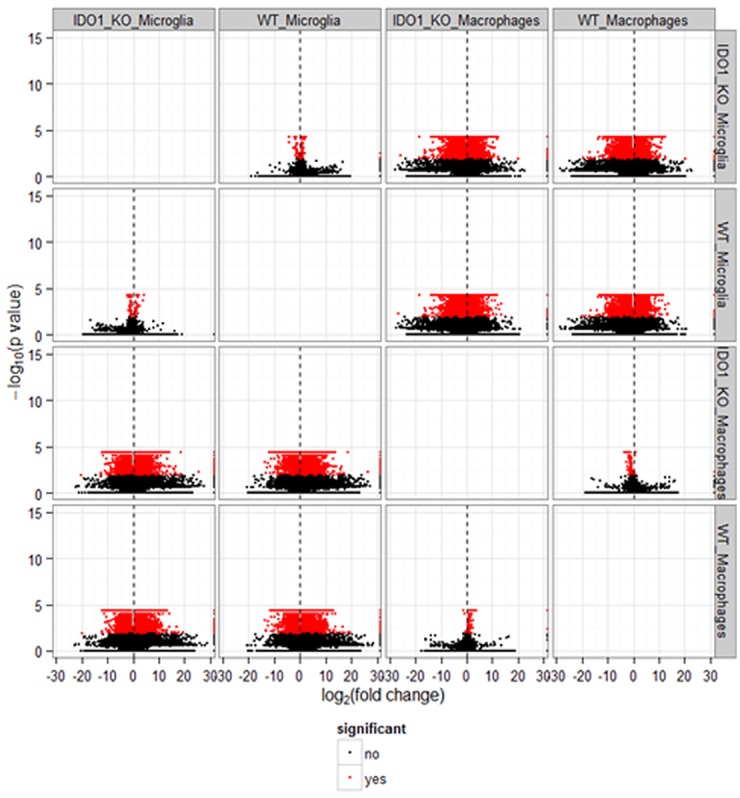
Volcano plots of transcript isoform differential expression between microglia and macrophage cells within strain and between IDO1-knock out (IDO1_KO) and wild type (WT) strains within cell type expressed in -10log10(P-value) in the y-axis versus log2(fold change) in the x-axis, where fold change is computed between the pair of cell type-strain combination labels.Red dots denote transcript isoforms differentially expressed at FDR-adjusted P-value < 0.05 (labeled significant yes) and black dots denote transcript isoforms not differentially expressed (labeled significant no).